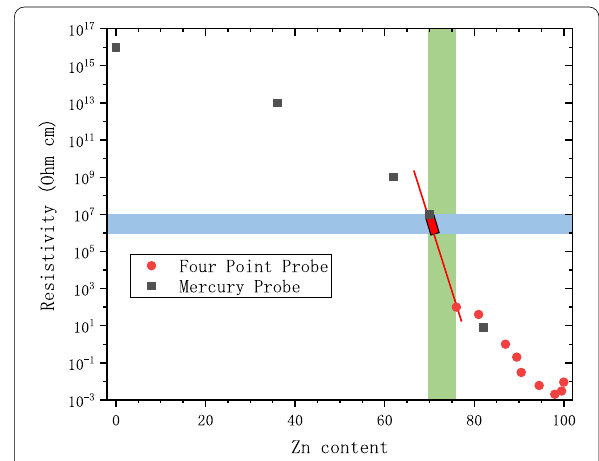
Fig. 2 Zn content, Zn/(Zn A)*100(%), blue area as the MCP + resistance area, green area as AZO change area, the red areas as the need area to